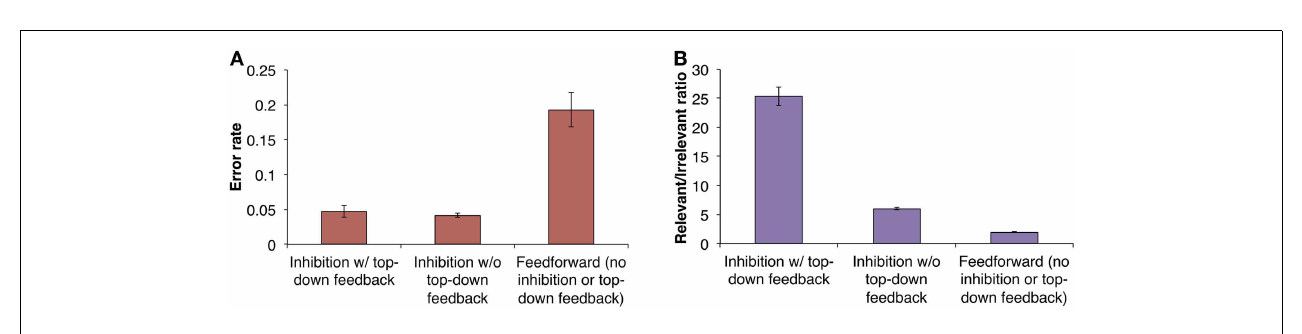
output (relevant responses) or not (irrelevant responses) suggests that the reason for the purely feedforward model’s poor performance was that it had a higher overall signal-to-noise ratio (mean relevant response divided by mean irrelevant response).This type of representation could lead to illusory feature conjunctions and thus, recognition